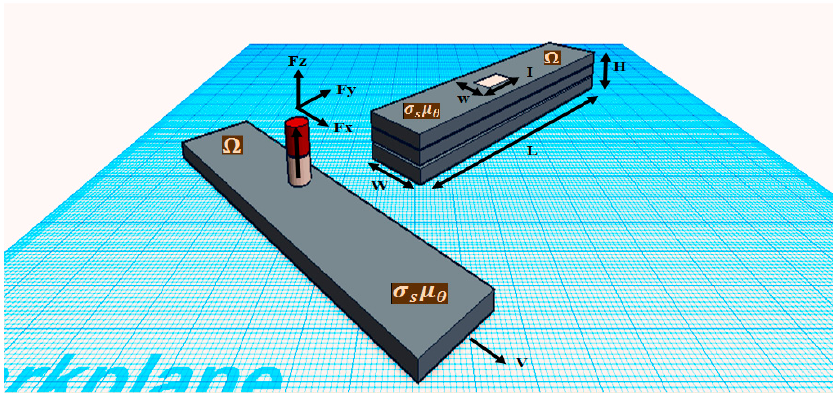
Figure 1. Lift-off Eddy Current Testing basic principle.